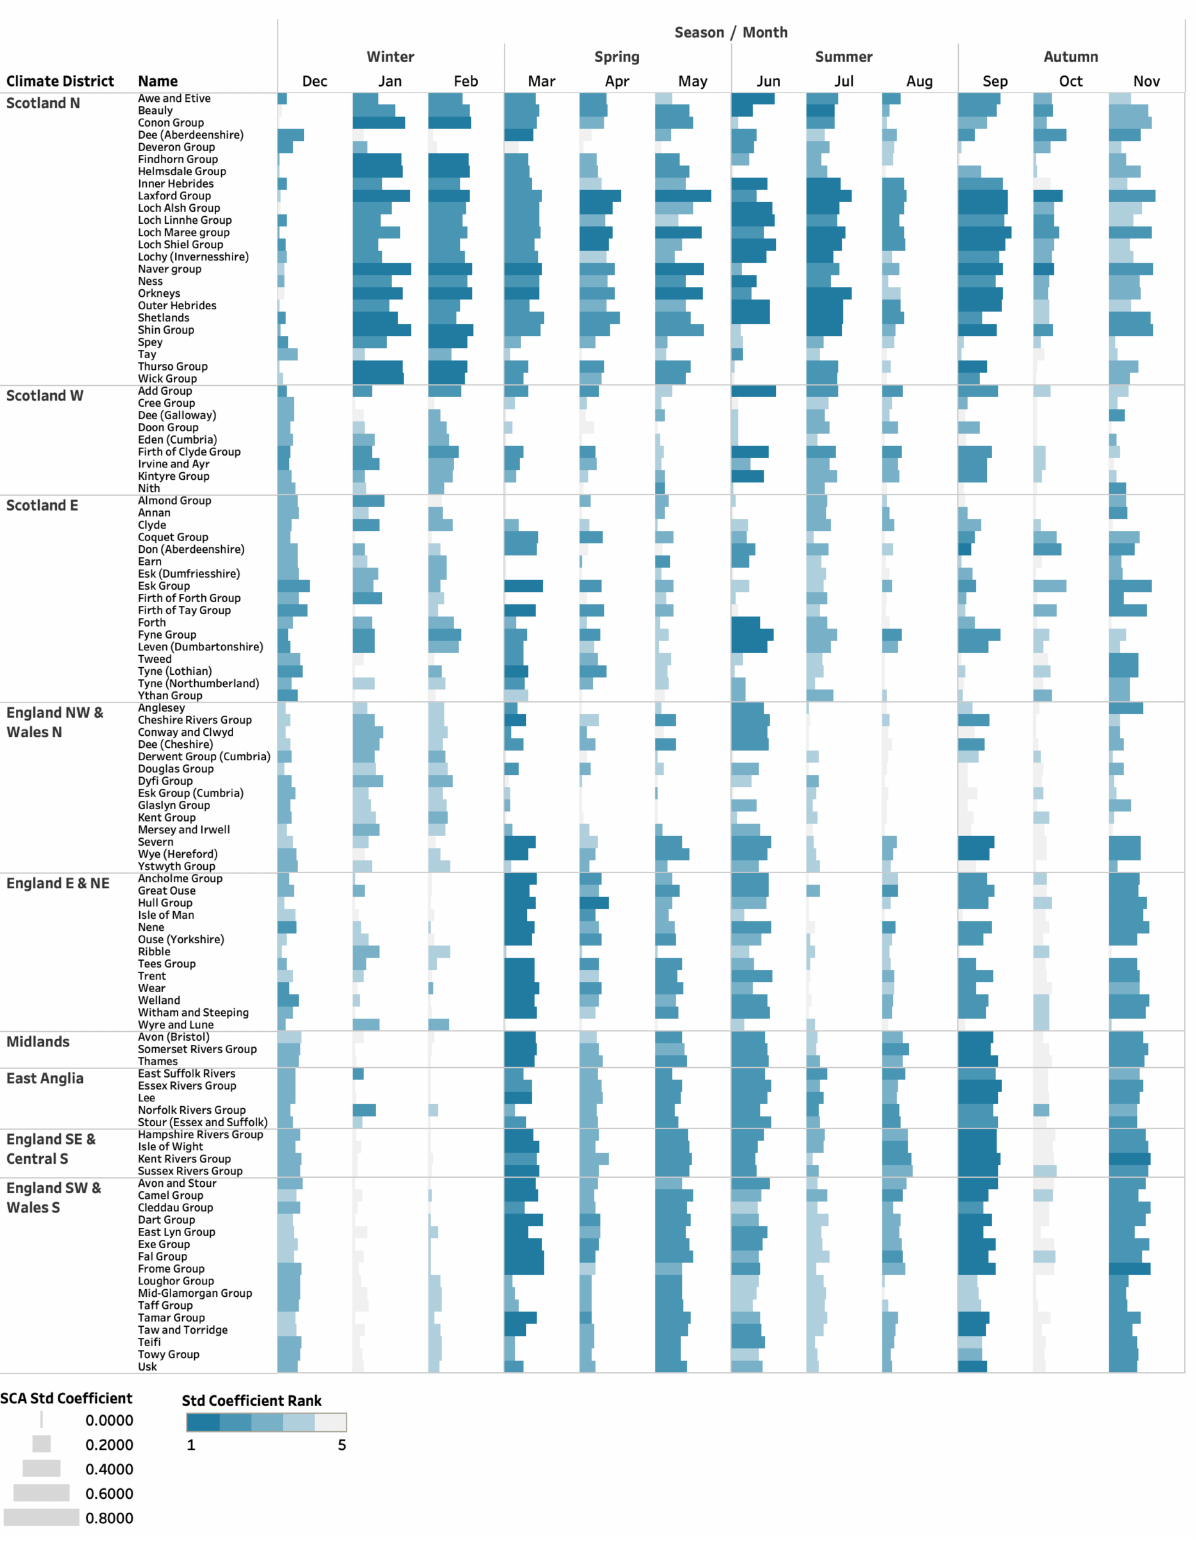
Figure A6. Rank of the SCA Standardised Coefficient. Colour represents the rank, with darker colours signifying greater influence (higher rank). Size is dependent on the magnitude of the